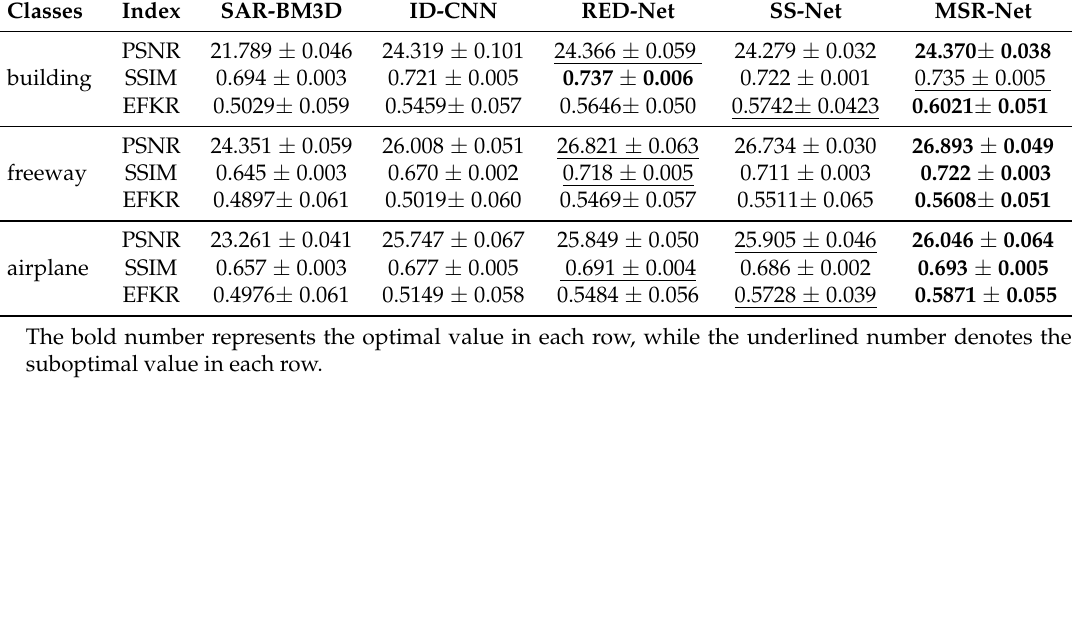
Table 2. The PSNR, SSIM, and EFKR of test set with noise level L = 4.